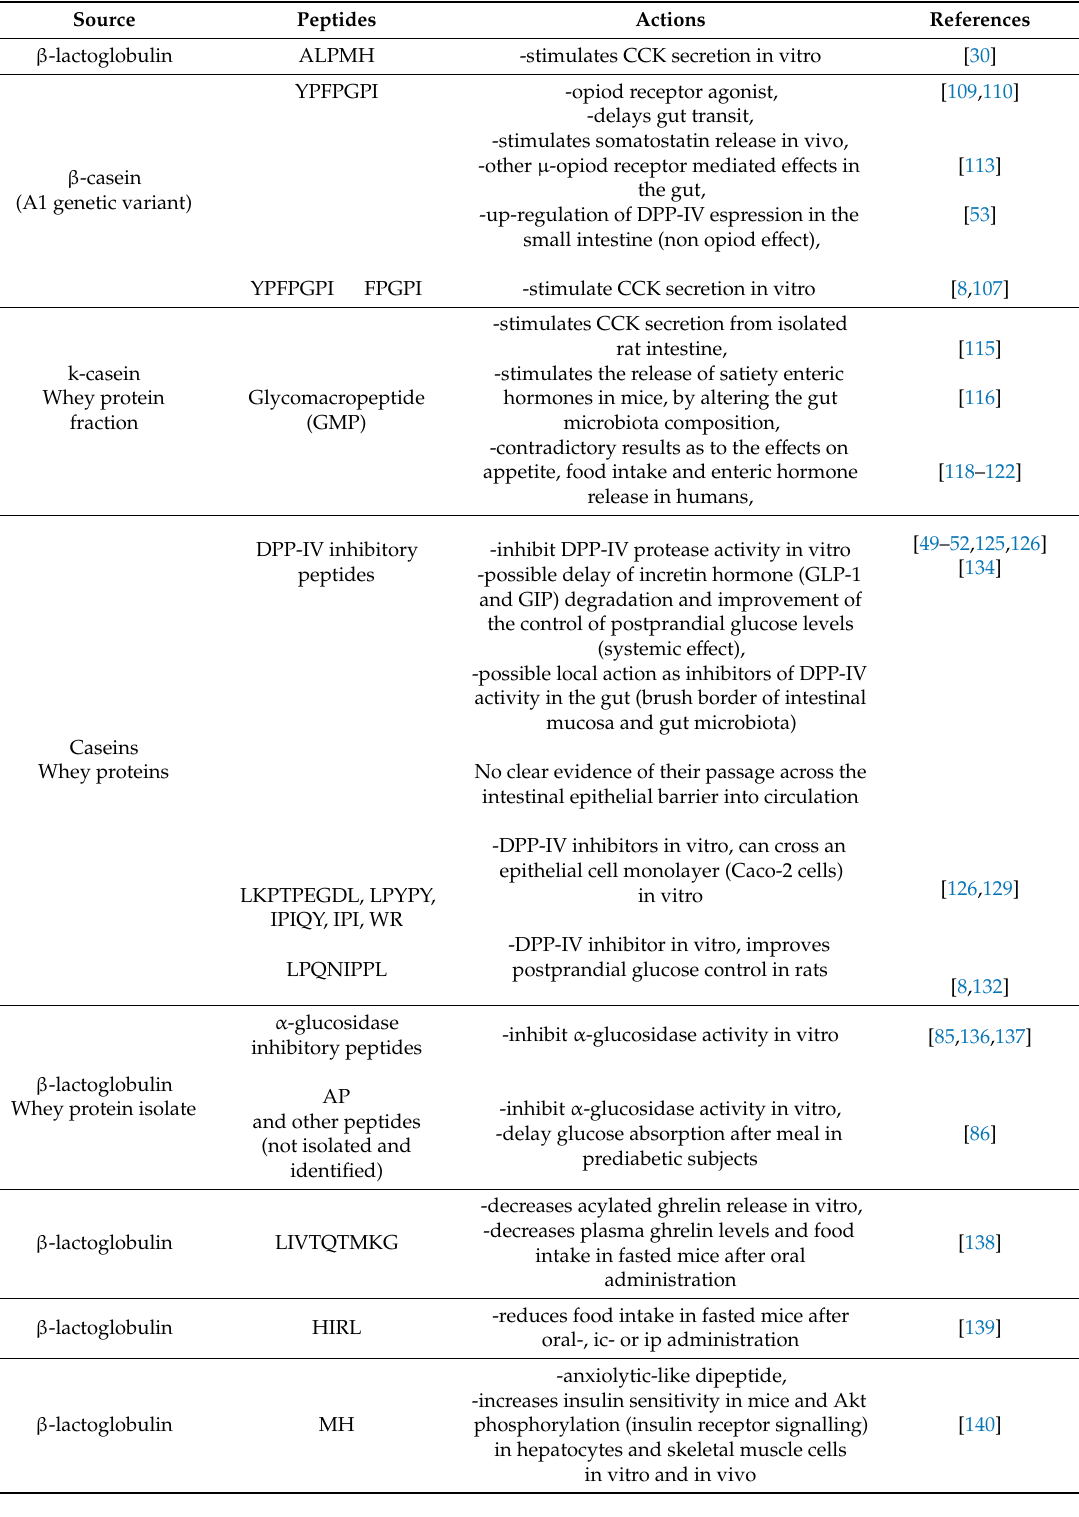
Table 1. A summary of bioactive peptides released during the enzymatic digestion of dairy proteins (bovine), and their in vitro and in vivo activities related to the control of food intake and glucose